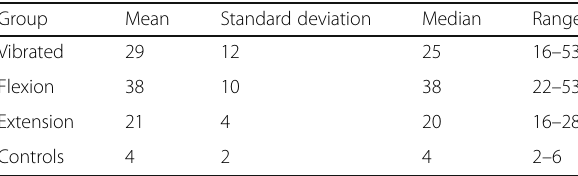
Table 4 The area (%) of unstained parts of the epiphyseal growth